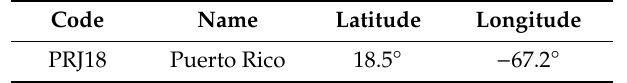
Table 1. The details of the mid-latitude ionosonde station in the Northern